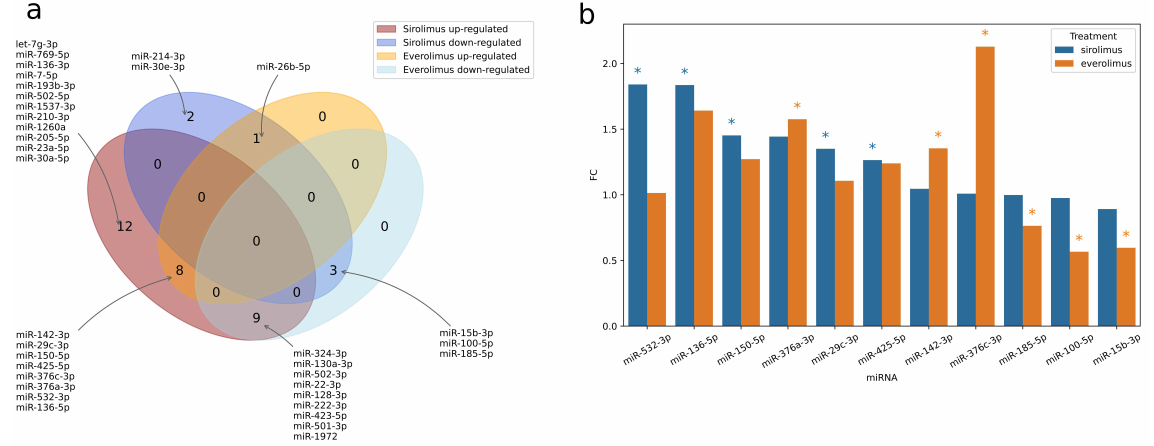
Figure 2. ( a ) Overlap of miRNA dysregulation on sirolimus and everolimus, including miRNAs significantly dysregulated after either of the two treatments. ( b ) miRNAs dysregulated in the same direction by sirolimus and everolimus treatment; asterisks mark significant dysregulation ( p < 0.05 in paired t